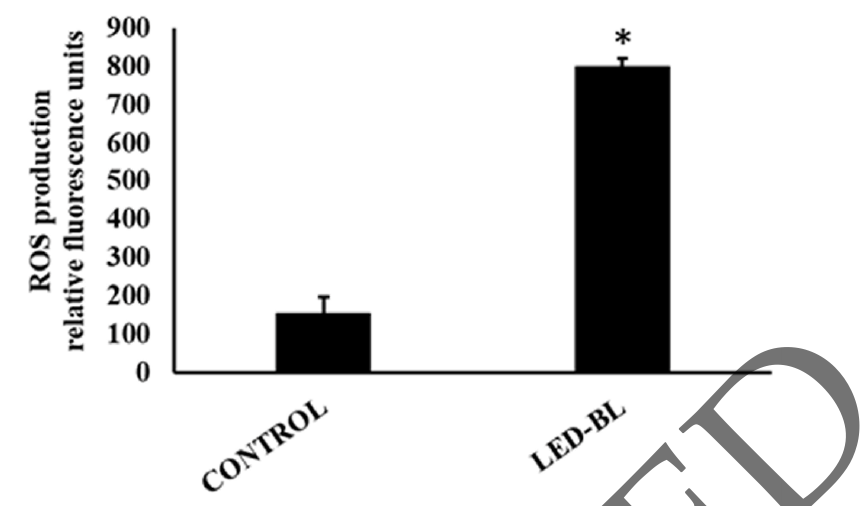
Figure 2. Production of reactive oxygen species (ROS) measured by 2’, 7’dichlorodihydrofluorescein diacetate (H2-DCFDA) assay. The results reported as relative fluorescence unit showed a significantly increased ROS level after treatment of NCTC 2544 with LED-BL at 45 J/cm 2 . Data represent mean ± SEM of three separate experiments performed in triplicate. * Significant versus untreated control; p ≤ 0.05.